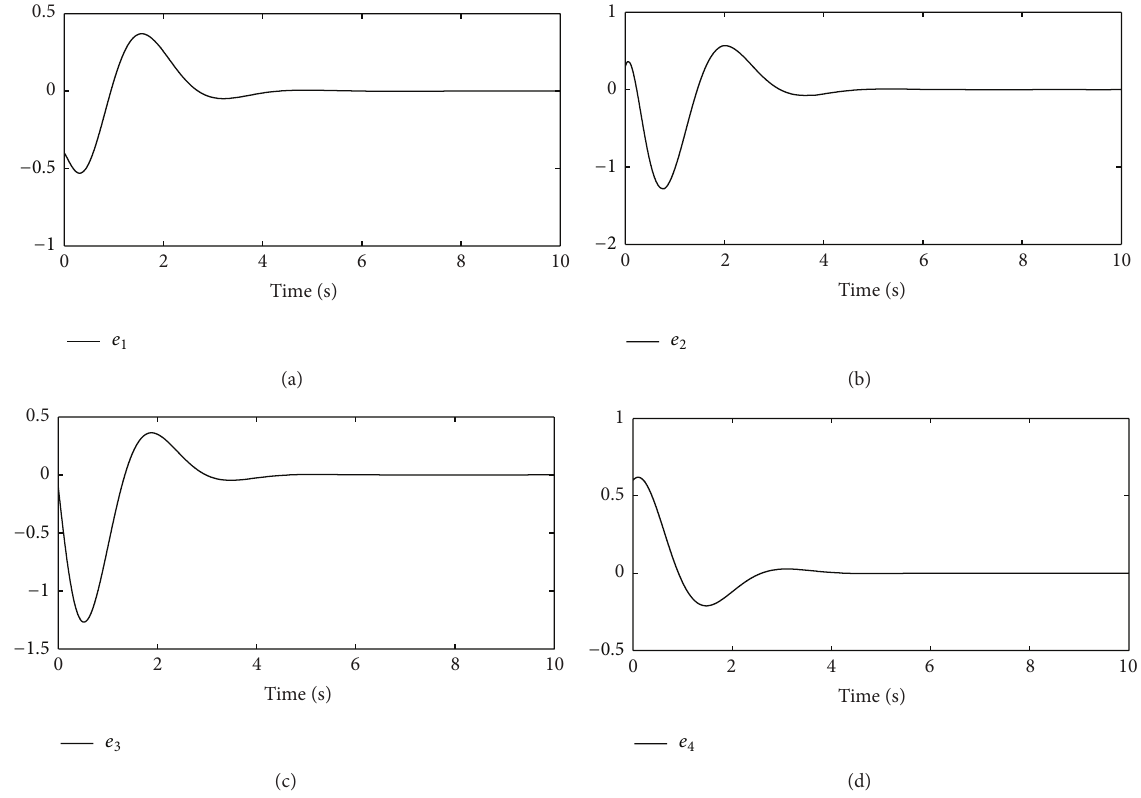
Figure 5: Error states of controlled drive and response systems: (a) error state of 𝑒 1 ; (b) error state of 𝑒 2 ; (c) error state of 𝑒 3 ; (d) error state of 𝑒 4 .